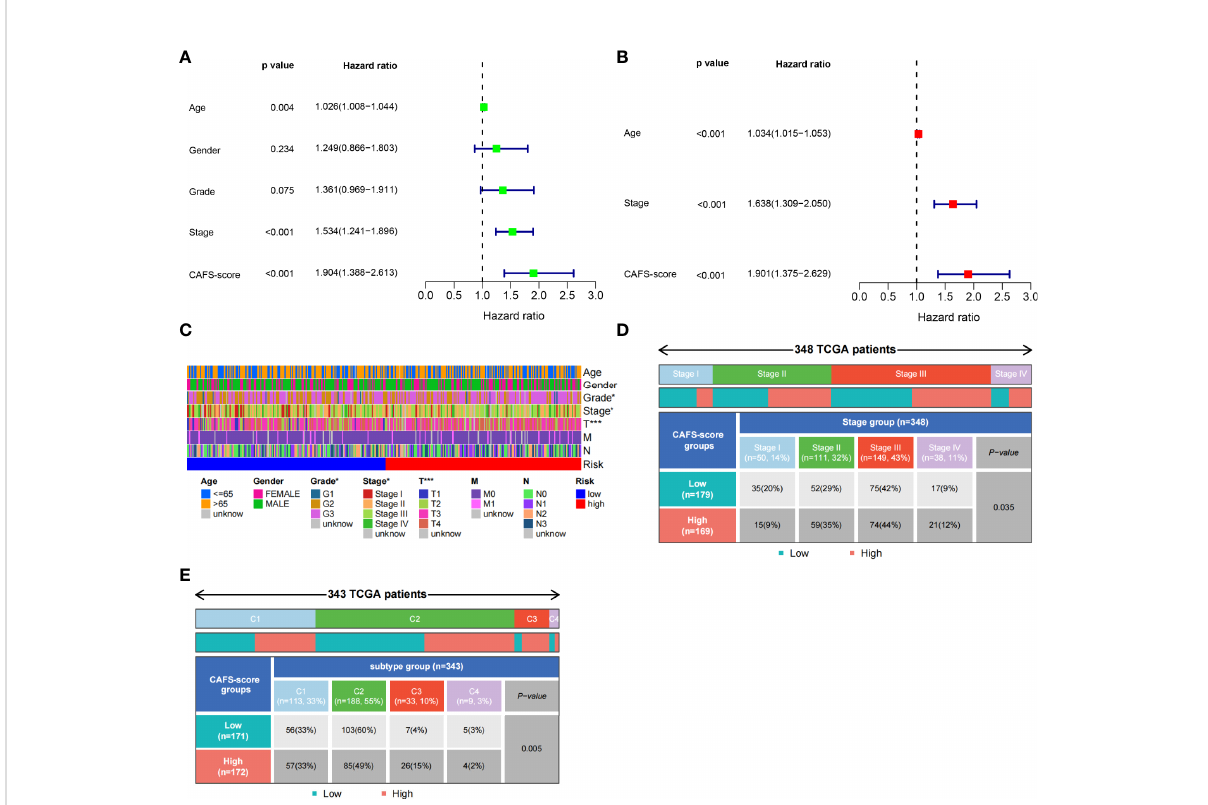
FIGURE 5 Clinicopathologic characteristics of TCGA in CAFS-score. (A) The Univariate Cox regression analysis in CAFS-score subgroups. (B) The multiple Cox regression analysis in CAFS-score subgroups. (C) The clinicopathologic characteristics of GC patients in the TCGA cohort. (D, E) The staging and the immune subtypes was signi fi cantly related to the risk between the two CAFS-score subgroups, respectively. *P<0.05,